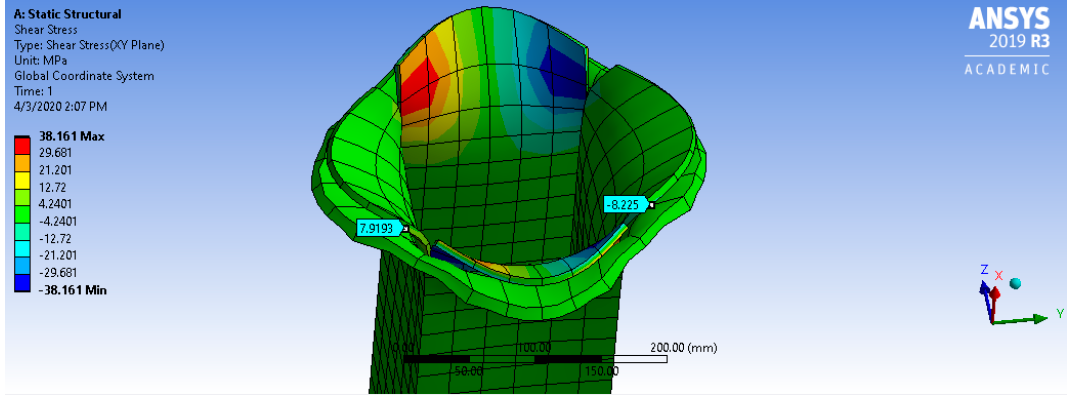
Figure 19. Shear stress at the interface between the glass sheets and HDPE for the 150 × 150 × 3 × 3. So, the worst-case design is that of the 89x38x3x1, which if loaded in the strong axis, the shear stress would become 30.69 MPa (as the ratio between the weak and strong axis buckling loads is